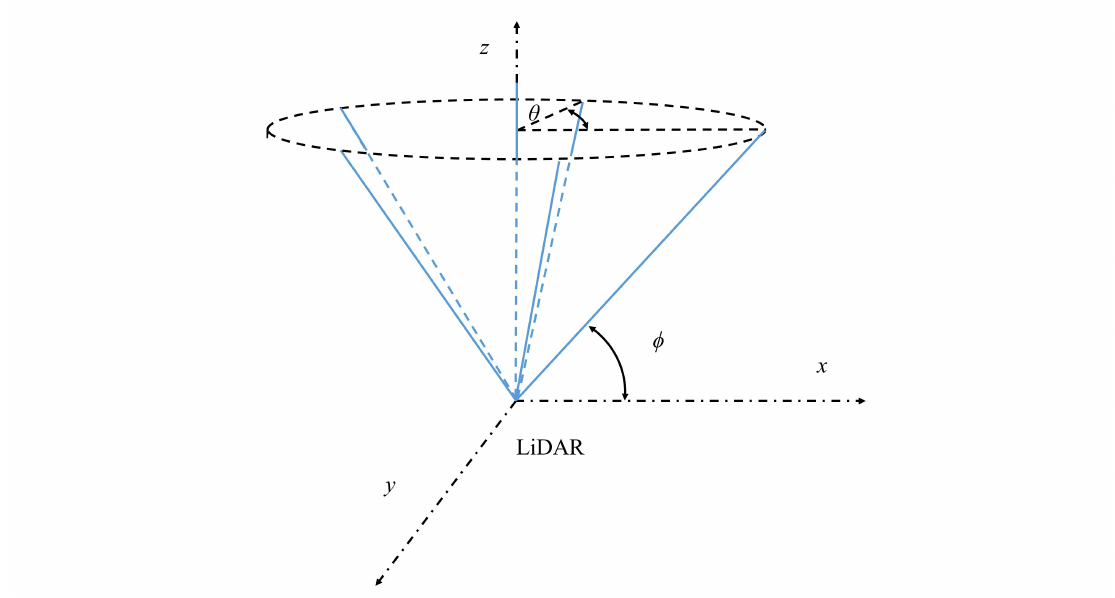
Figure 4. Schematic diagrams of DBS scan. LiDAR is placed at the origin of the Cartesian coordinate